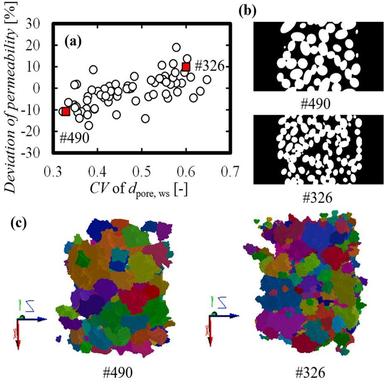
(a) Relationship between the deviation index of the permeability and the CV of dpore, ws. Sample #490 (small CV of dpore, ws) and sample #326 (large CV) are shown as examples. (b) Cross-sectional images of the two samples. (c) Watershed-based segmented pores colored individually for #490 and #326.